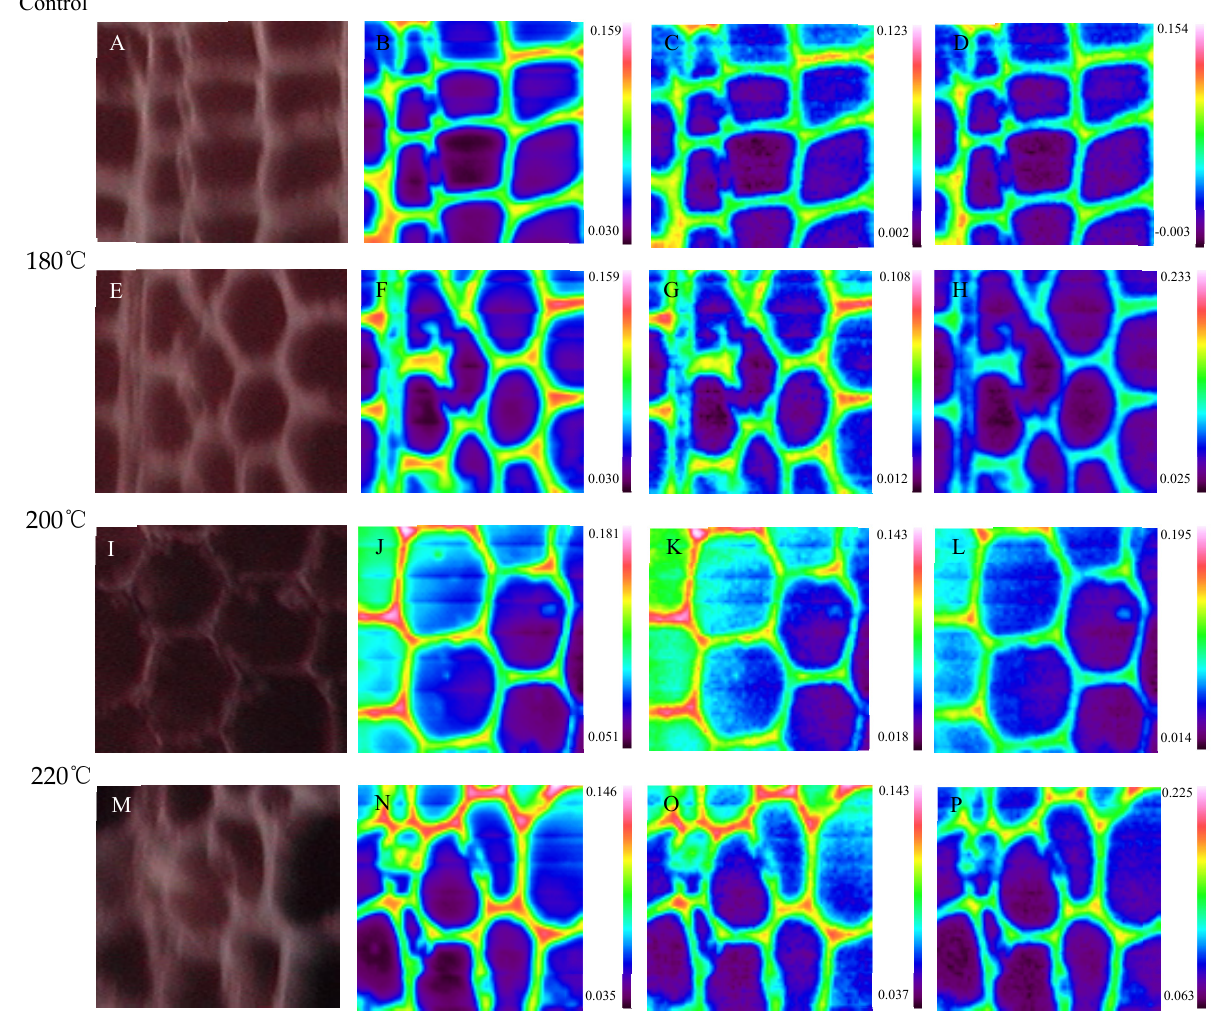
Figure 8. Visual images ( A , E , I , M ), total absorbance images ( B , F , J , N ), and single wavenumber im- ages of EW before and after vacuum heat treatment. Spectral images generated with the peak at 1734 cm − 1 ( C , G , K , O ), spectral images generated with the peak at 1508 cm − 1 ( D , H , L , P ).